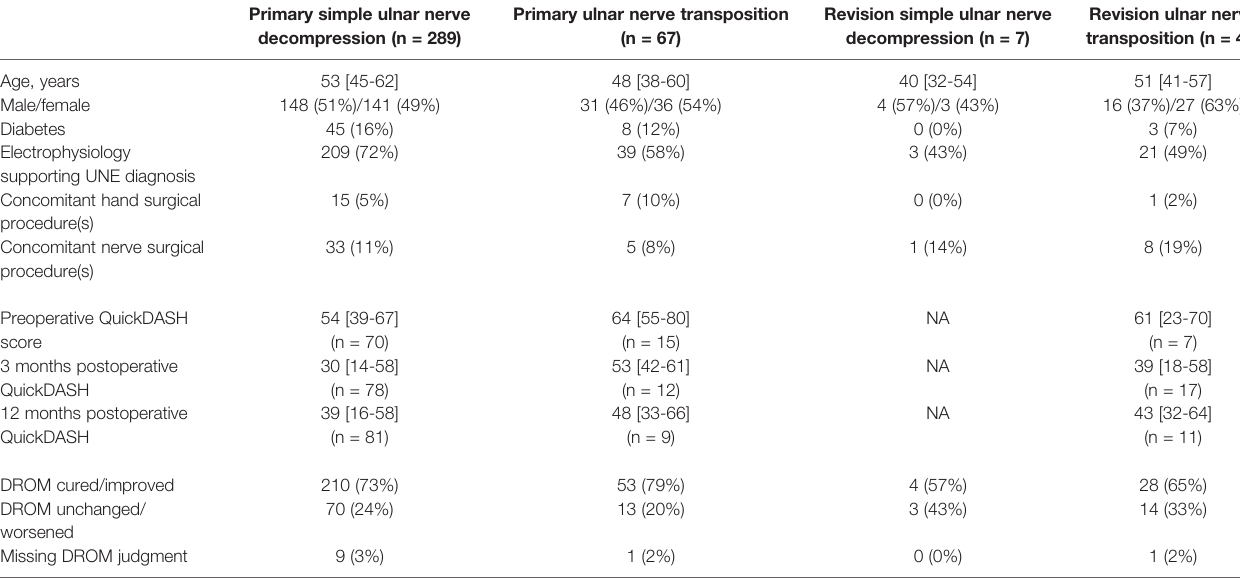
TABLE 1 | Characteristics of 406 surgically treated cases with ulnar nerve entrapment (UNE) grouped by surgical procedure performed at two hand surgery units. Primary simple ulnar nerve Primary ulnar nerve transposition decompression (n = 289) (n =